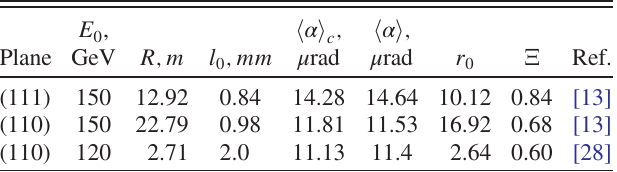
TABLE IV. Experimental data for the mean volume reflection angle for negatively charged particles in bent silicon crystals. Here h α i c and h α i are the calculated and measured values of the volume reflection angle at E 0 ¼ 400 GeV. r 0 ¼ R=R 0 and Ξ ¼ h α i = θ c